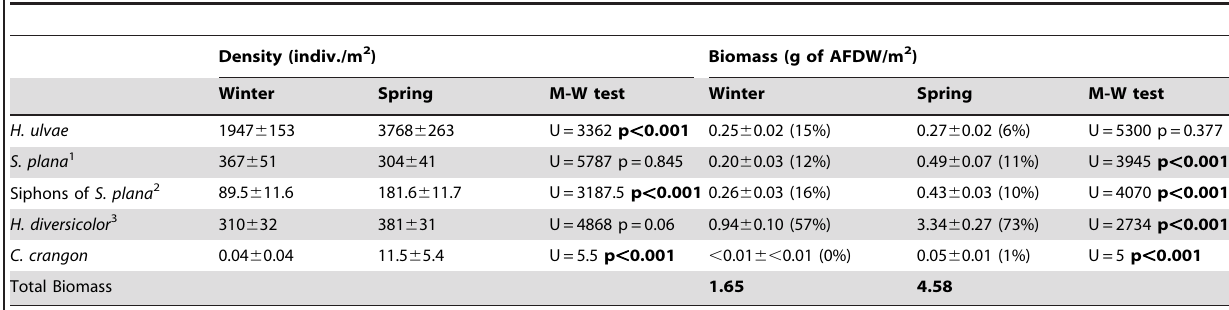
Table 3. Seasonal variation in harvestable density and biomass of main Dunlin prey species in winter and spring.